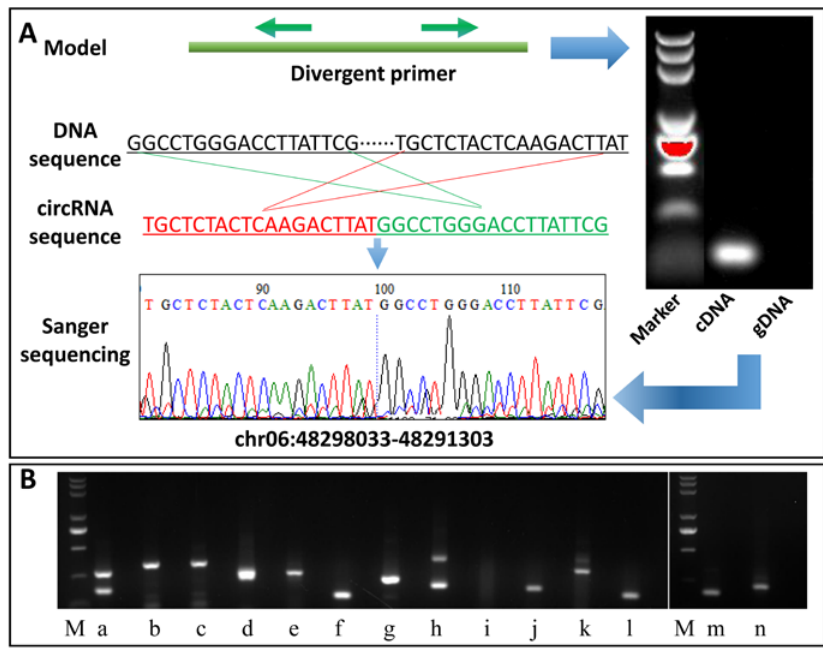
Figure 5. circRNAs validation by RT-PCR and Sanger sequencing. ( A ) A representative example